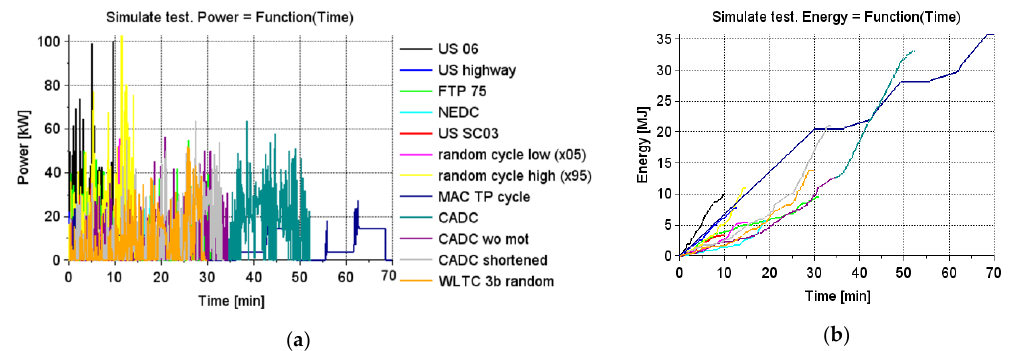
Figure 9. Results obtained in the simulation of selected road tests for the 2013 Mercedes E350 vehicle: ( a ) Waveforms of the instantaneous values of power generated by the engine; ( b ) Waveforms of the instantaneous values of mechanical energy generated by the vehicle engine.